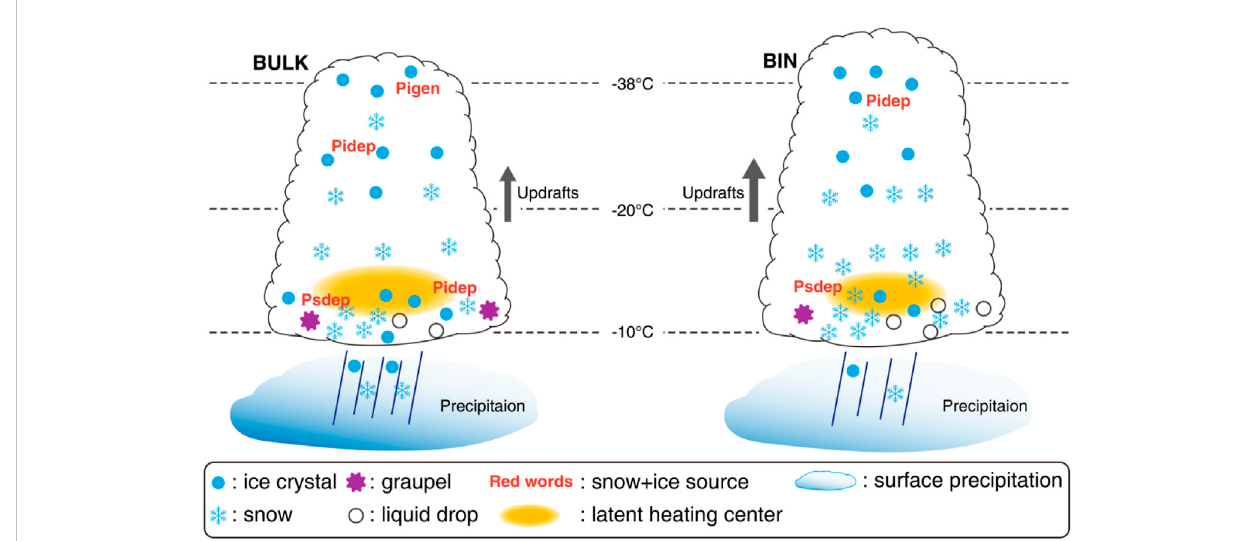
Schematic depicting the differences in the simulations between the BULK and BIN